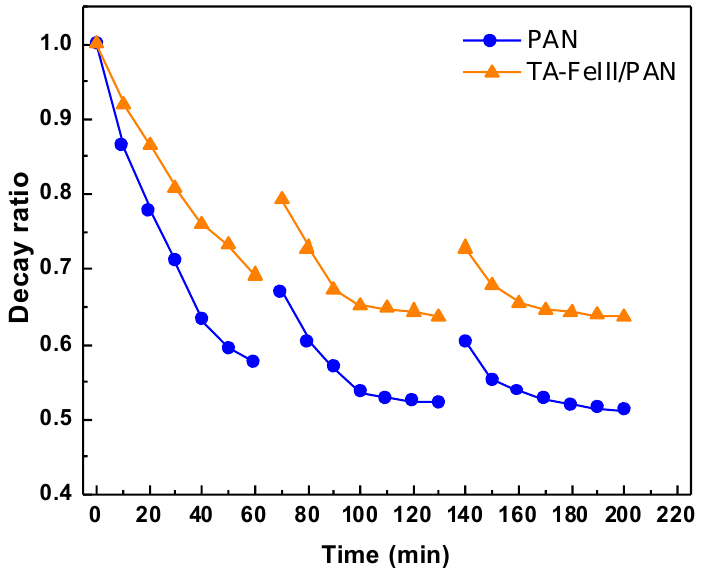
Figure 6. Reusability test of PAN and TA-FeIII membranes. Feed: H 2 O/diesel (99/1) emulsion at 1 bar.